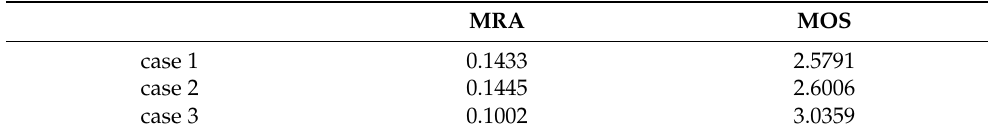
Table 1. Root mean square error of MRA and MOS.